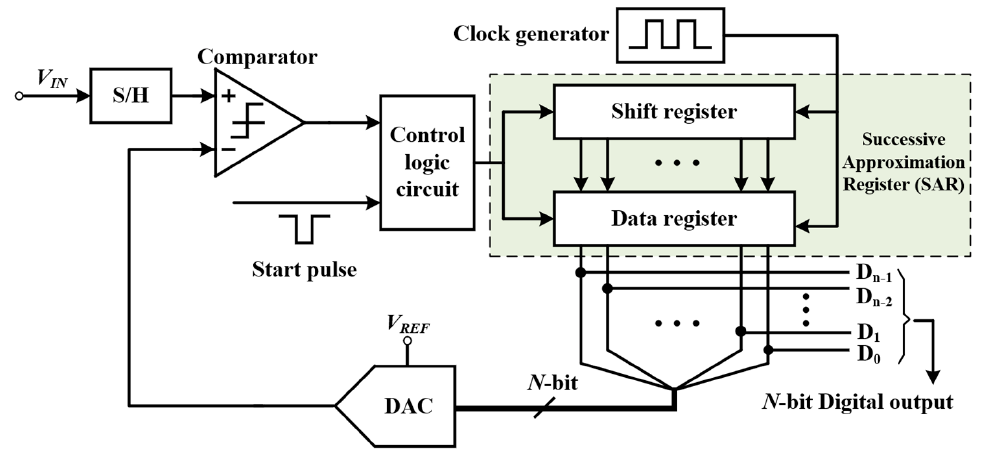
Figure 3. Basic structure diagram of SAR ADC.